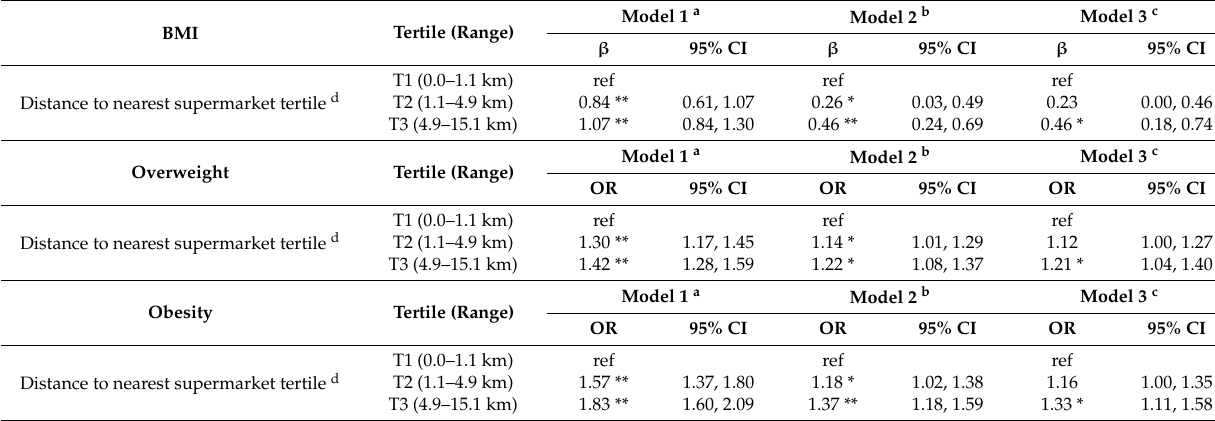
Table 2. Associations of tertiles of distance to the nearest supermarket with body mass index (estimated using a multiple linear regression model), overweight and obesity (estimated using a single multinomial logistic regression model), in the Fenland Study sample ( n =